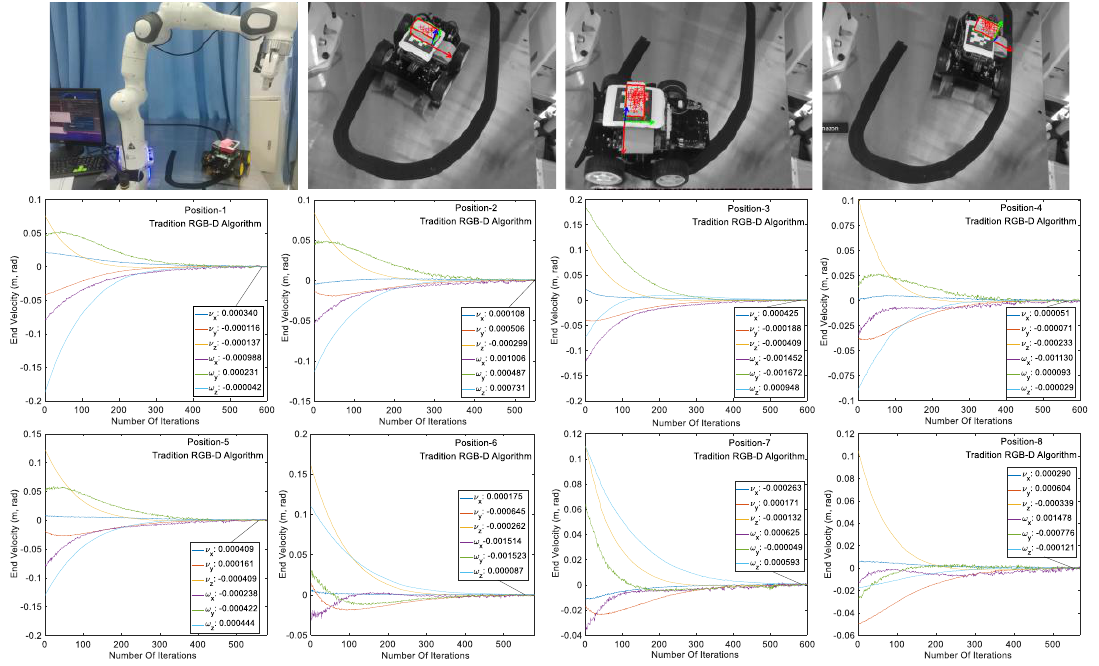
Figure 12. Manipulator speed change of traditional RGB-D image processing algorithm.